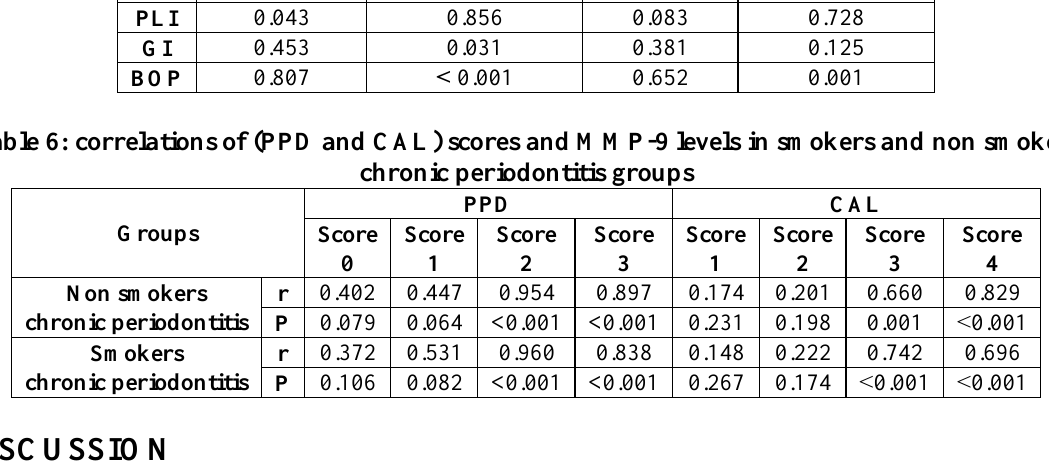
periodontitis groups as shown in the table (1).